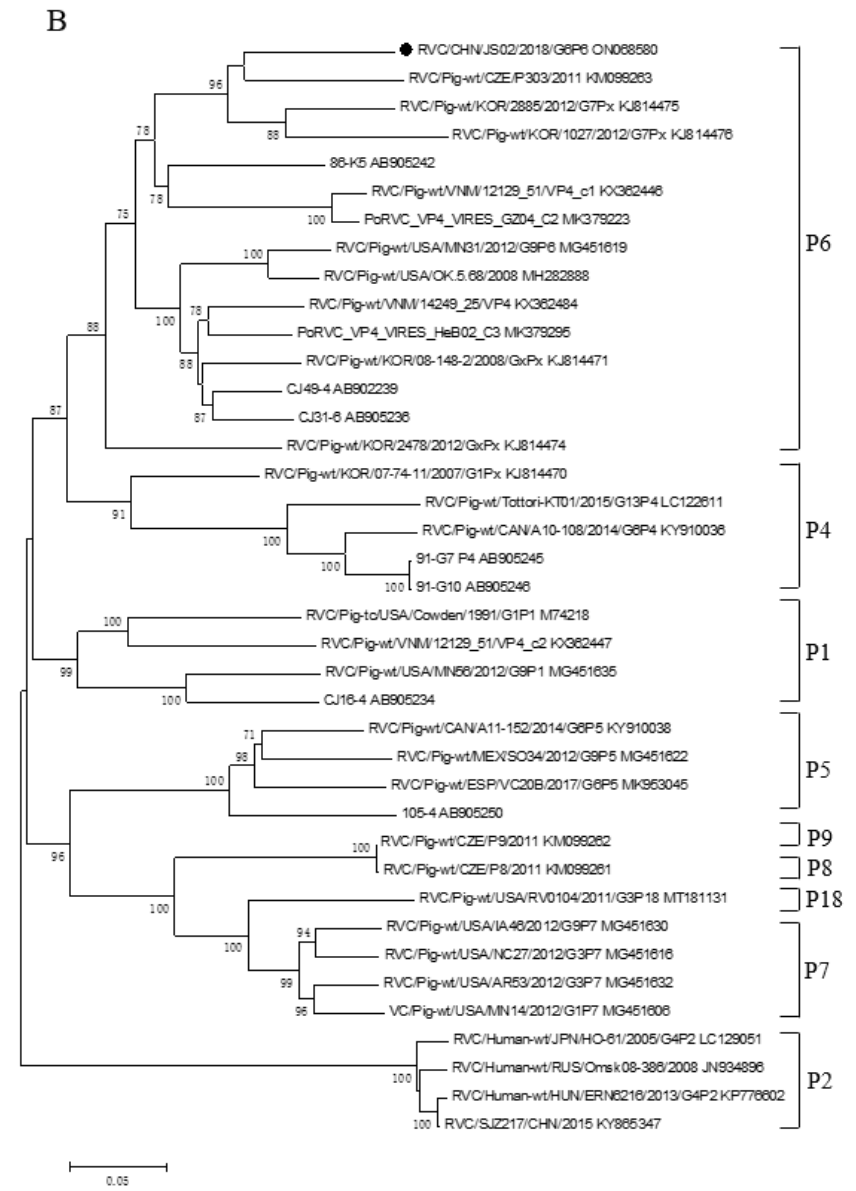
Figure 2. Phylogenetic analysis of RVC/Pig/China/JS02/2018/G6P6. ( A ) VP7 gene; ( B ) VP4 gene. The sequences of NSP1, NSP2, NSP3, NSP4, and NSP5 were analyzed